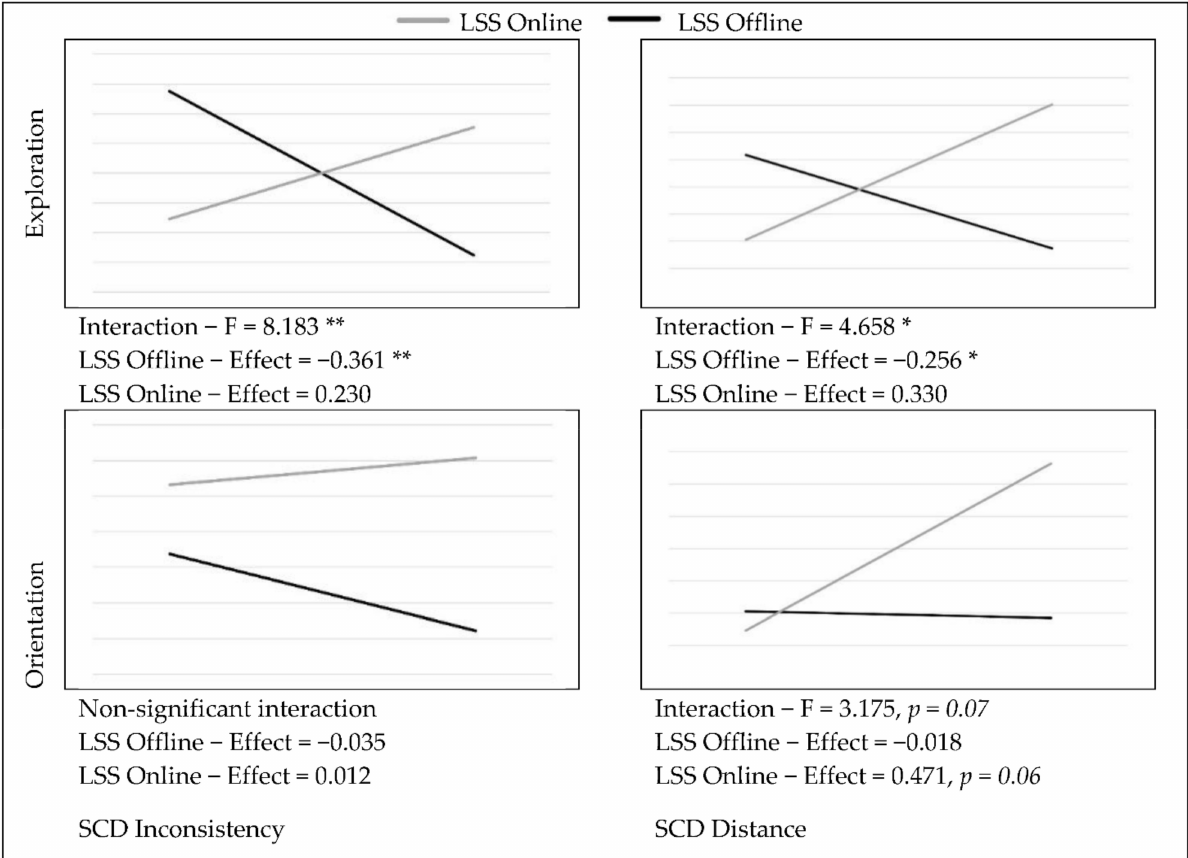
Figure 2. Effects of SCD on Sexual Identity (standardized means). * p < 0.05, ** p < 0.01.